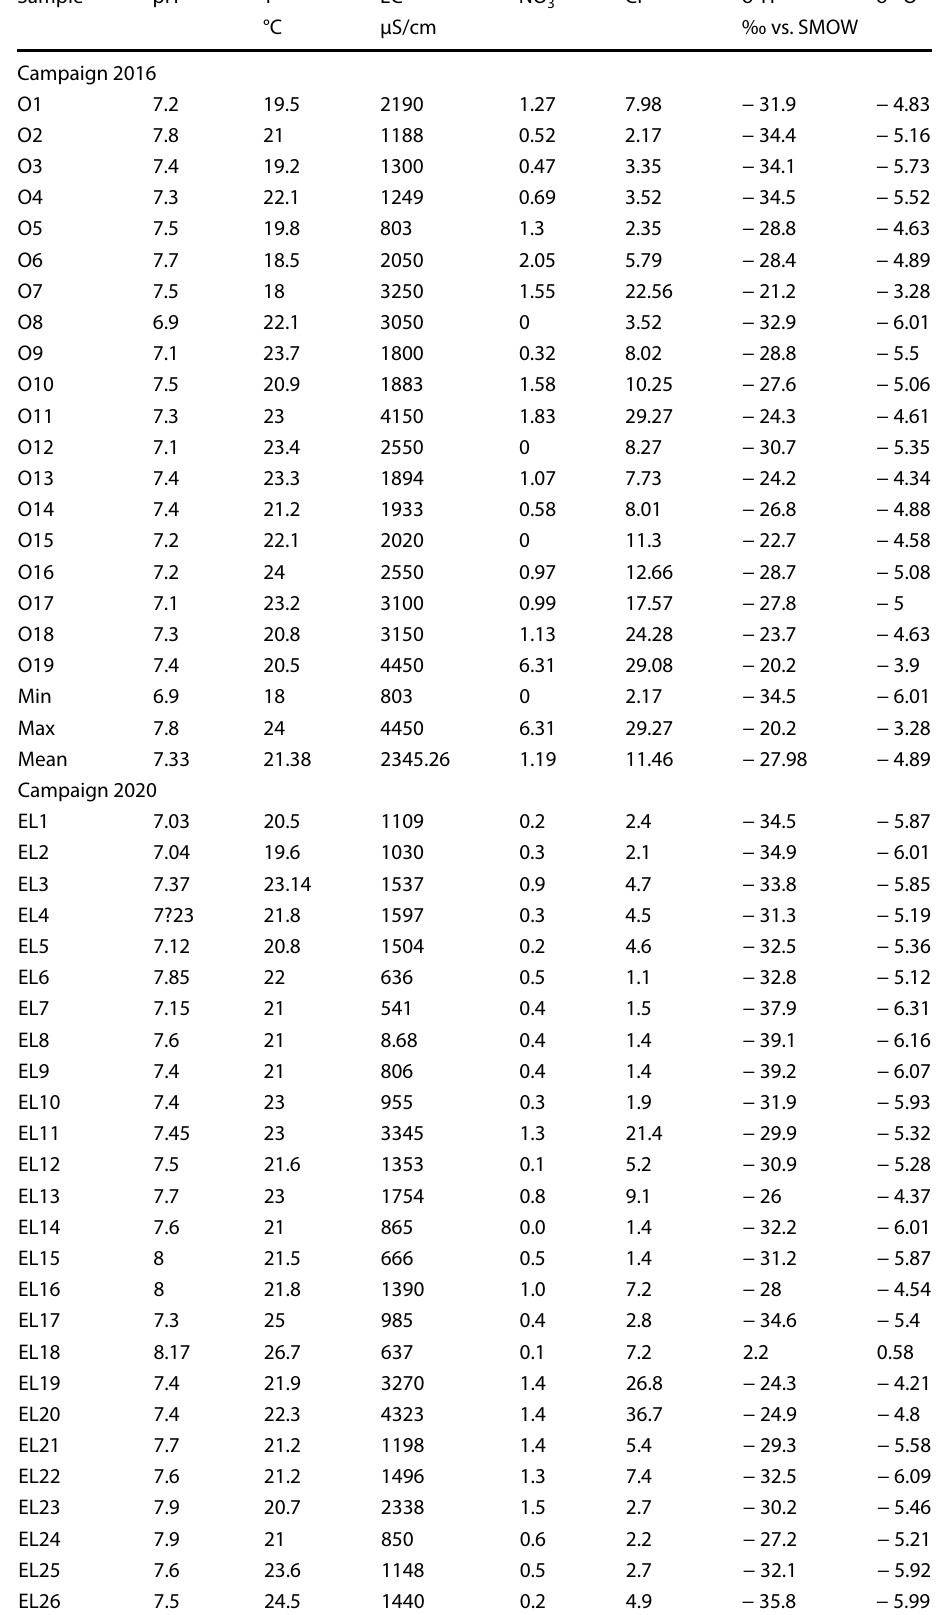
Table 4 Statistical summary of the stable isotopic values